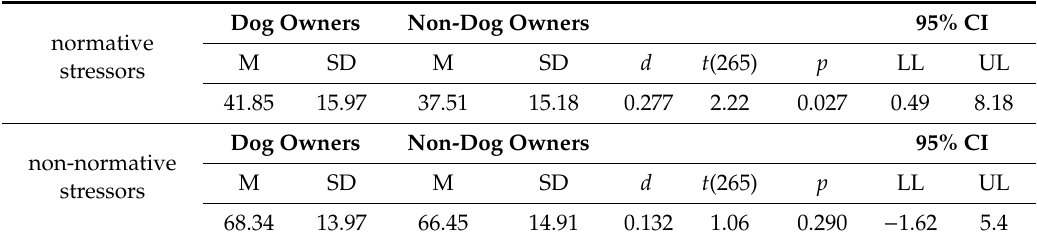
Table 2. Mean di ff erences between the groups “dog owners” and “non-dog owners” regarding the assessment of normative and non-normative